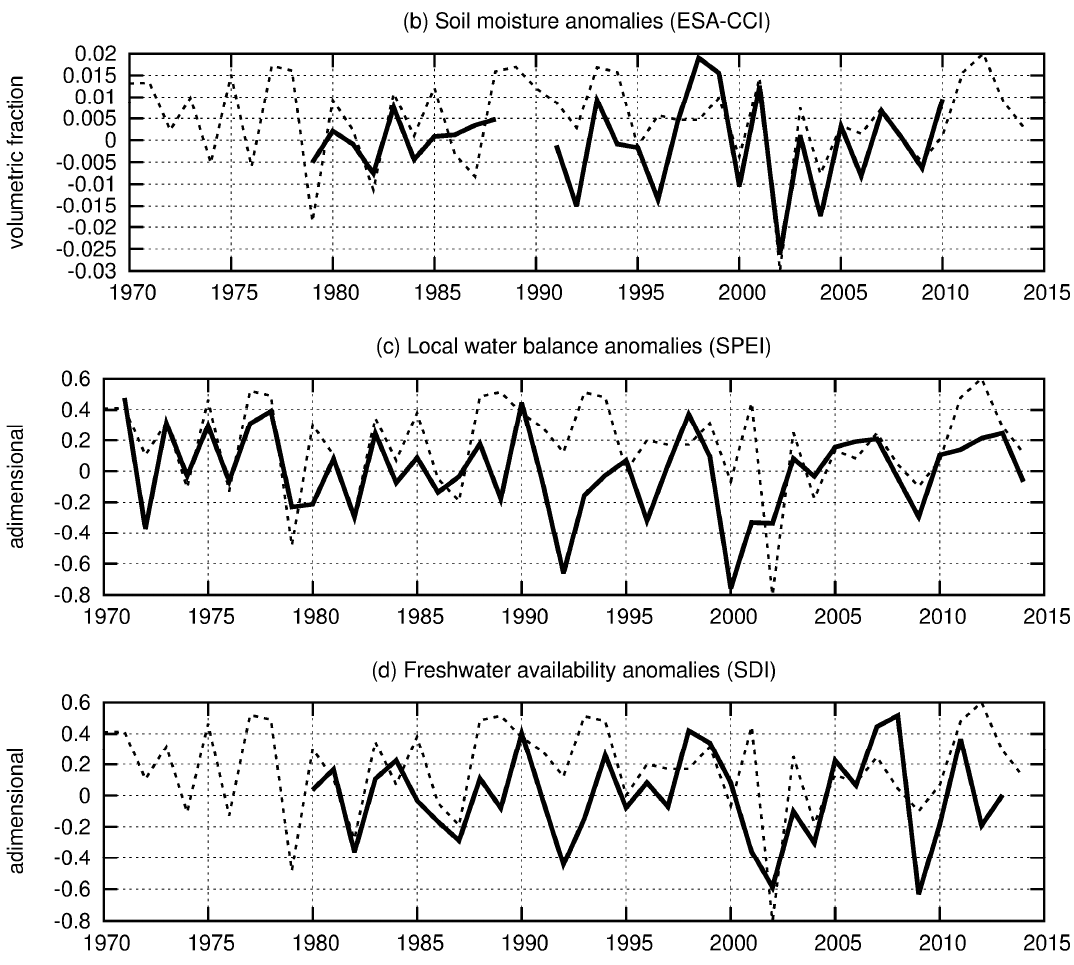
Figure 6. Time series of yield anomalies (panel ( a )—bold line, drawn as dashed lines in all the other panels); top soil moisture observations (ESA-CCI, panel ( b )); climate indicators for the local water balance (SPEI, panel ( c )) and freshwater availability (SRDI, panel ( d )). All indexes are aggregated at the national level over all cropping cycles.